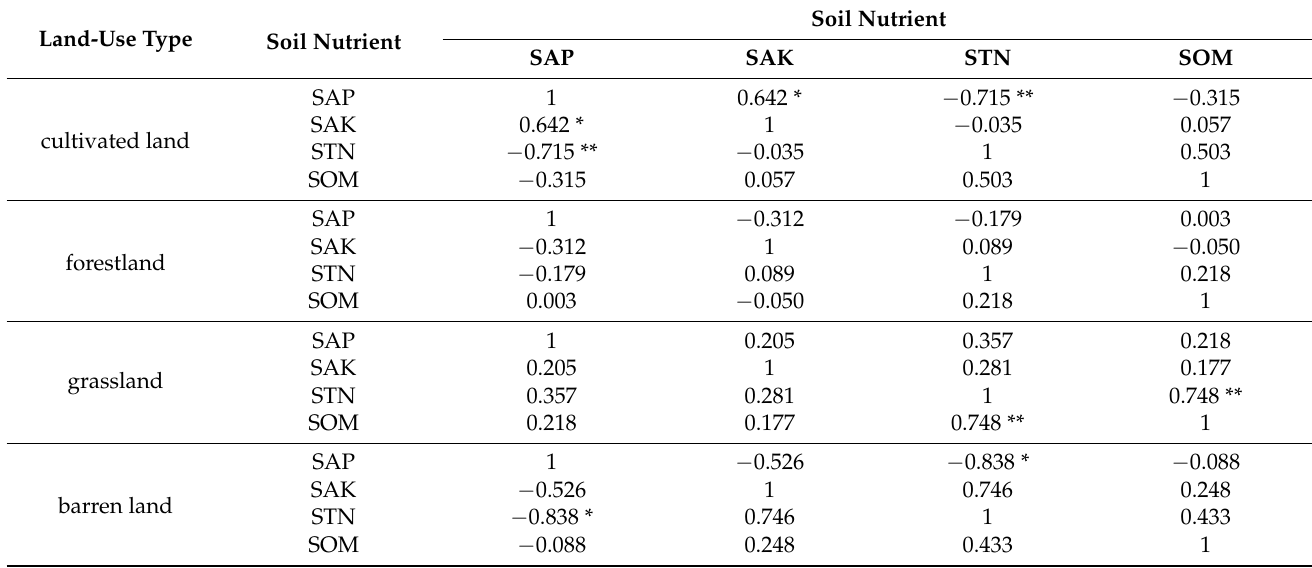
Table 3. Pearson correlation coefficients between soil nutrients under different land-use types in